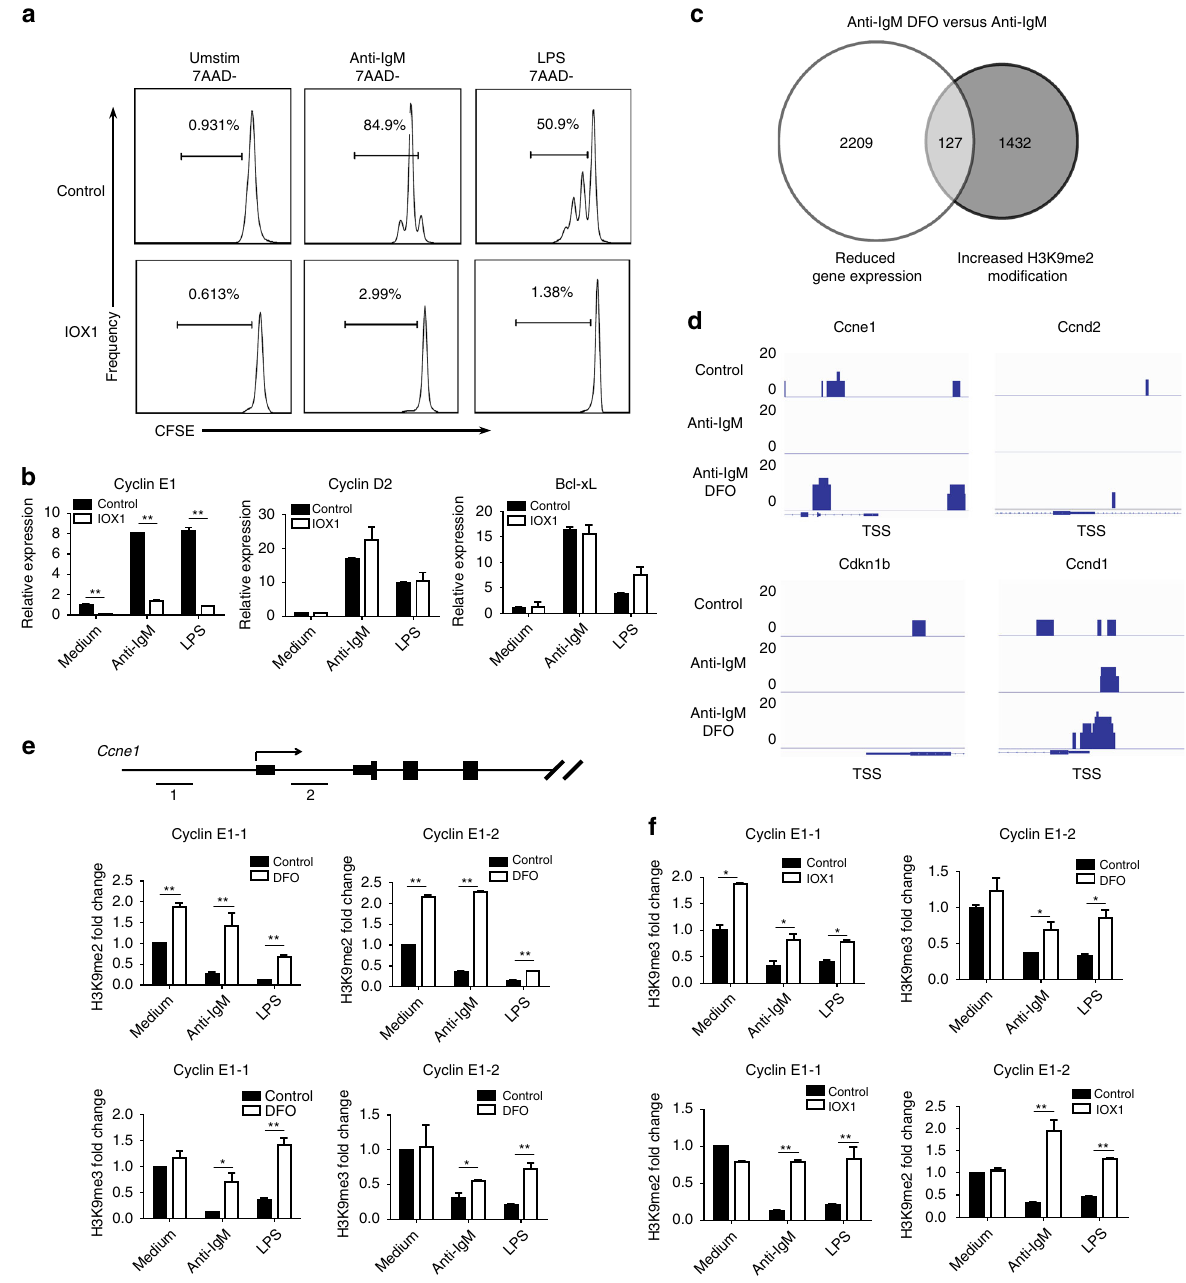
Fig. 7 Iron deprivation impairs Cyclin E1 induction through inhibiting H3K9me3/2 demethylation. a Flow cytometry of CFSE-labeled B-cell proliferation following stimulation with anti-IgM (10 µ g/ml) or LPS (2 µ g/ml) for 72 h in the presence of the 2-OG inhibitor IOX1 (100 µ M) or dimethyl sulfoxide (DMSO) as a control. b Results of qRT-PCR to analyze cyclin E1, cyclin D2, and Bcl-xL induction 48 h after anti-IgM or LPS stimulation in control and 2-OG- inhibited B cells. c Venn diagram indicating the overlap of genes with reduced expression and increased H3K9me2 modi fi cations in iron-de fi cient B cells. d ChIP-seq analysis of H3K9me2 modi fi cations in control and iron-de fi cient B cells post BCR stimulation. The results for four representative cell cycle- related genes are shown in the graph. e Results of ChIP-qRT-PCR to con fi rm changes in H3K9me3/H3K9me2 modi fi cation near the TSS of cyclin E1 in control and iron-de fi cient B cells following BCR or TLR stimulation for 48 h. The numbers and horizontal lines show the locations of the ChIP-qRT-PCR primers. f ChIP-qRT-PCR to analyze changes in H3K9me3/2 near the cyclin E1 TSS in control and 2-OG-inhibited B cells 48 h post stimulation. All graphs with error bars indicate the mean ± SEM, and * P < 0.05, ** P < 0.01, Student ’ s t